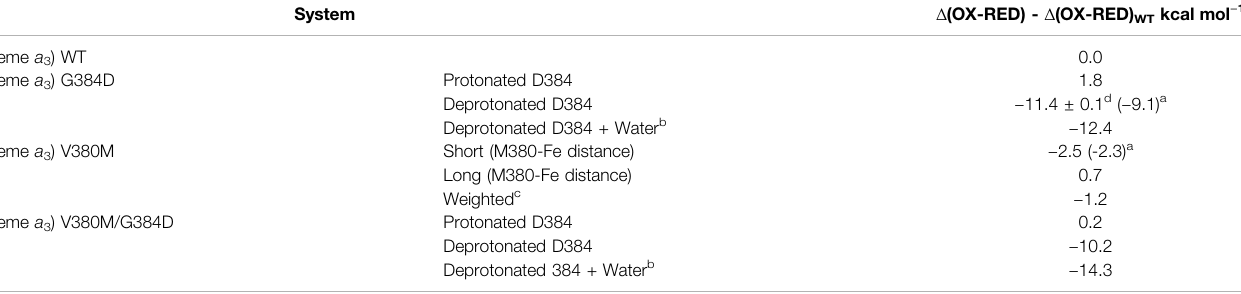
TABLE 1 | Electron af fi nity of heme a 3 in WT and mutants.